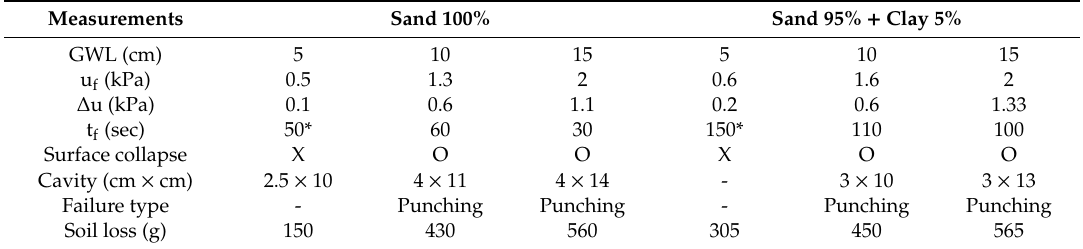
Table 1. Summary of the test results for the sand and sand-clay mixtures.